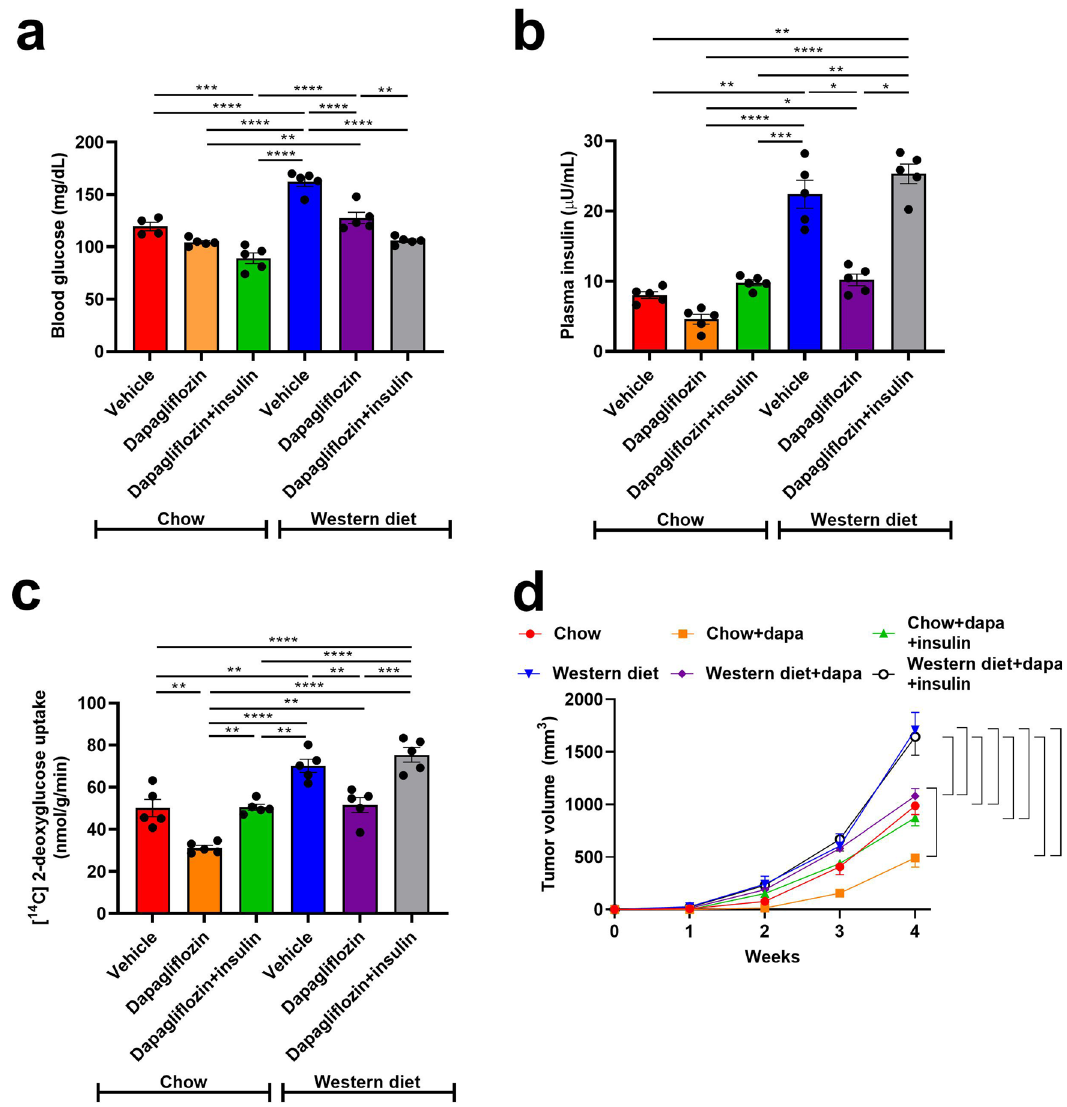
Fig. 3 Dapagli fl ozin slows orthotopic 4T1 tumor growth in lean and obese mice, correlated with its effect to lower plasma insulin concentrations. a Blood glucose and ( b ) Plasma insulin in 6 h fasted mice. c Tumor [ 14 C] 2-deoxyglucose uptake. In panels ( a – c ), * P < 0.05, ** P < 0.01, *** P < 0.001, **** P < 0.0001 by ANOVA with Tukey ’ s multiple comparisons test. n = 5 per group. d Tumor growth. Data are the mean ± S.E.M. of n = 5 per group. The brackets denote statistically signi fi cant ( P < 0.05) comparisons by ANOVA with Tukey ’ s multiple comparisons